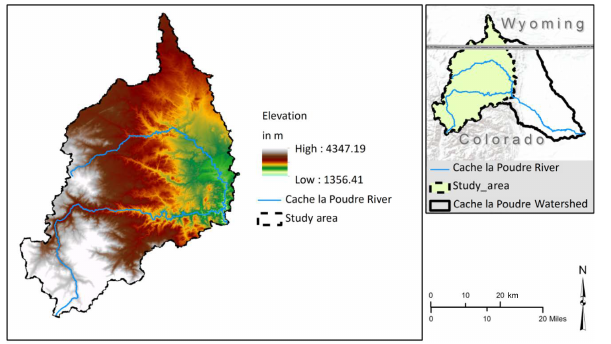
Figure A2. Distribution of major LULC types in study watershed based on MRLC’s NLCD 2011 Land Cover dataset.